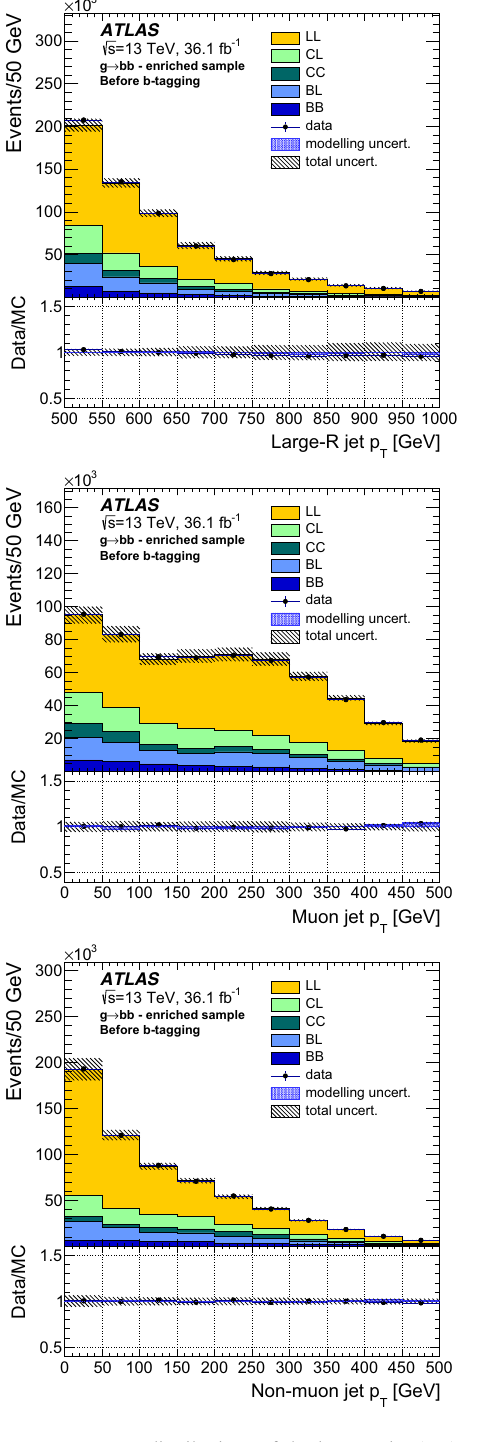
generator modelling and the b -tagging-related uncertainties, are shown as well. The total uncertainty includes all systematic uncertainties listed in Sect. 5 and the fit uncertainty summed in